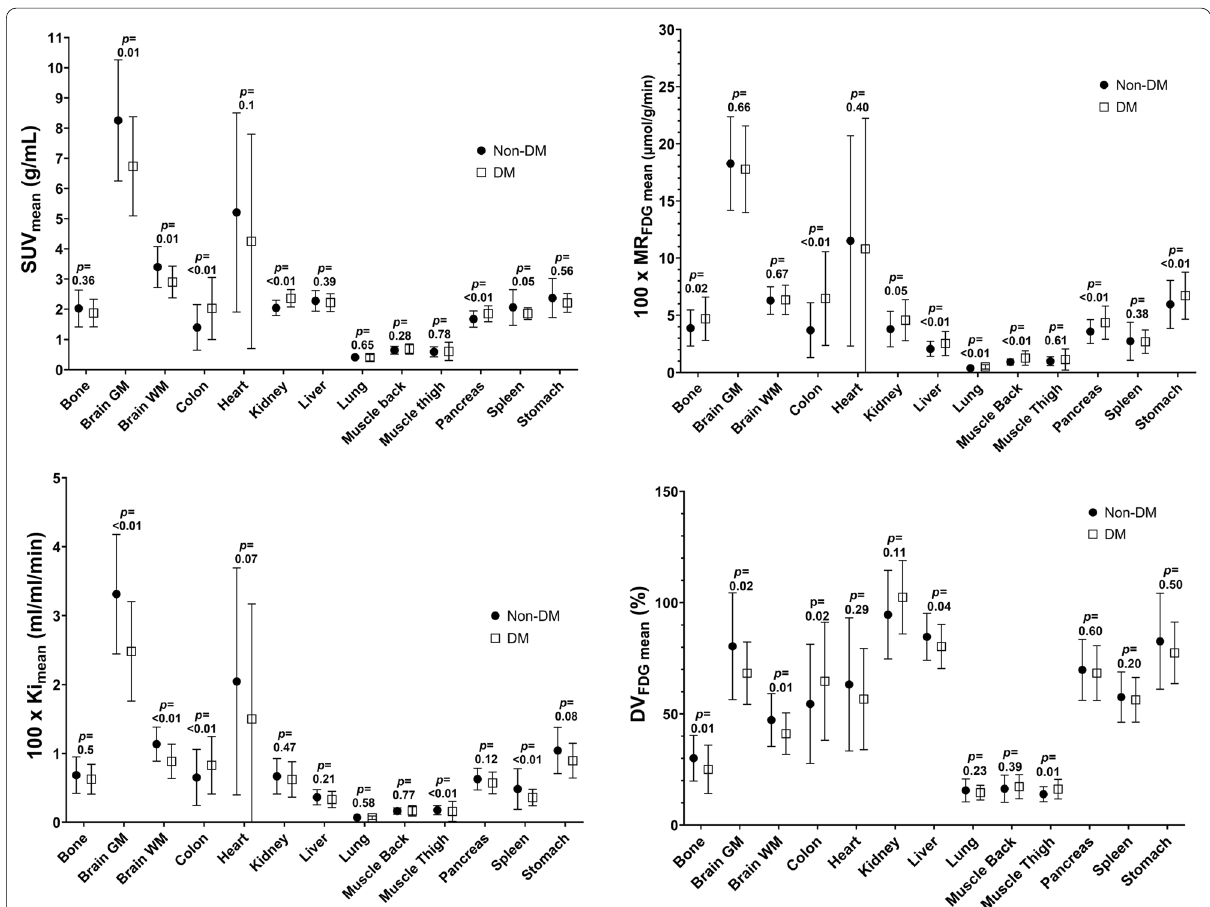
Fig. 2 Distribution plots of SUV mean , MR FDG,mean , K i ,mean and DV FDG,mean for the DM and Non-DM populations in 13 different types of tissue and organs. Plotted are the mean and standard deviation values. As seen, population variation was remarkably similar for SUV and MR FDG values. Calculated p -values between patients with DM and without DM are displayed above each organ